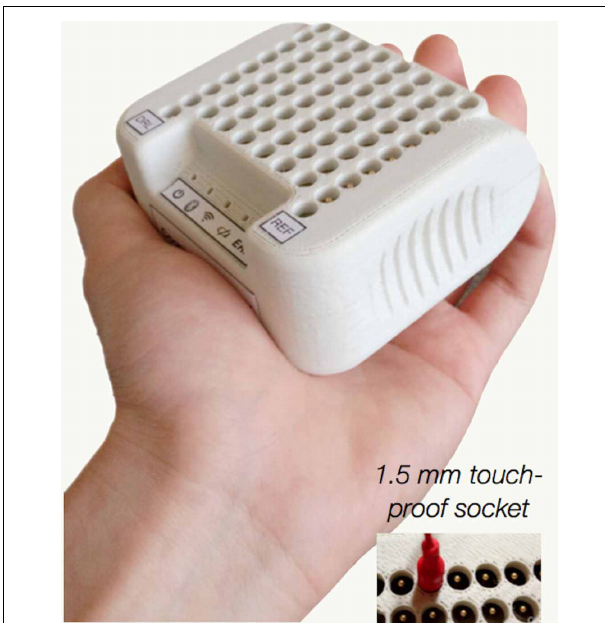
FIGURE 8 | Cognionics wireless EEG acquisition unit. This unit holds the digitizers, amplifier, micro controller and wireless receiver. It is designed to work with standard 1.5mm touchproof lead wires. Picture, courtesy of Cognionics (Cognionics, Inc., San Diego, CA